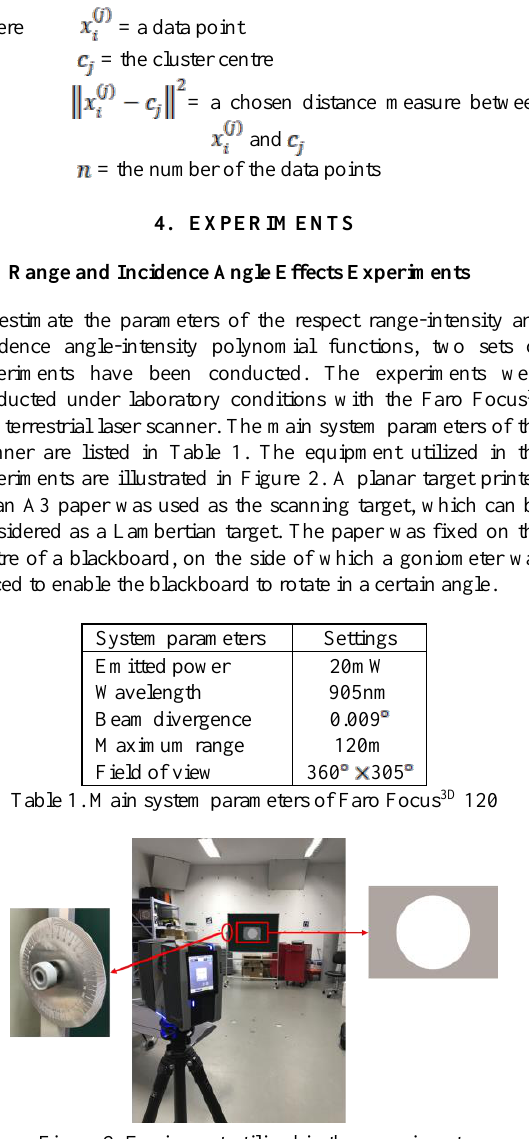
Figure 2. Equipment utilized in the